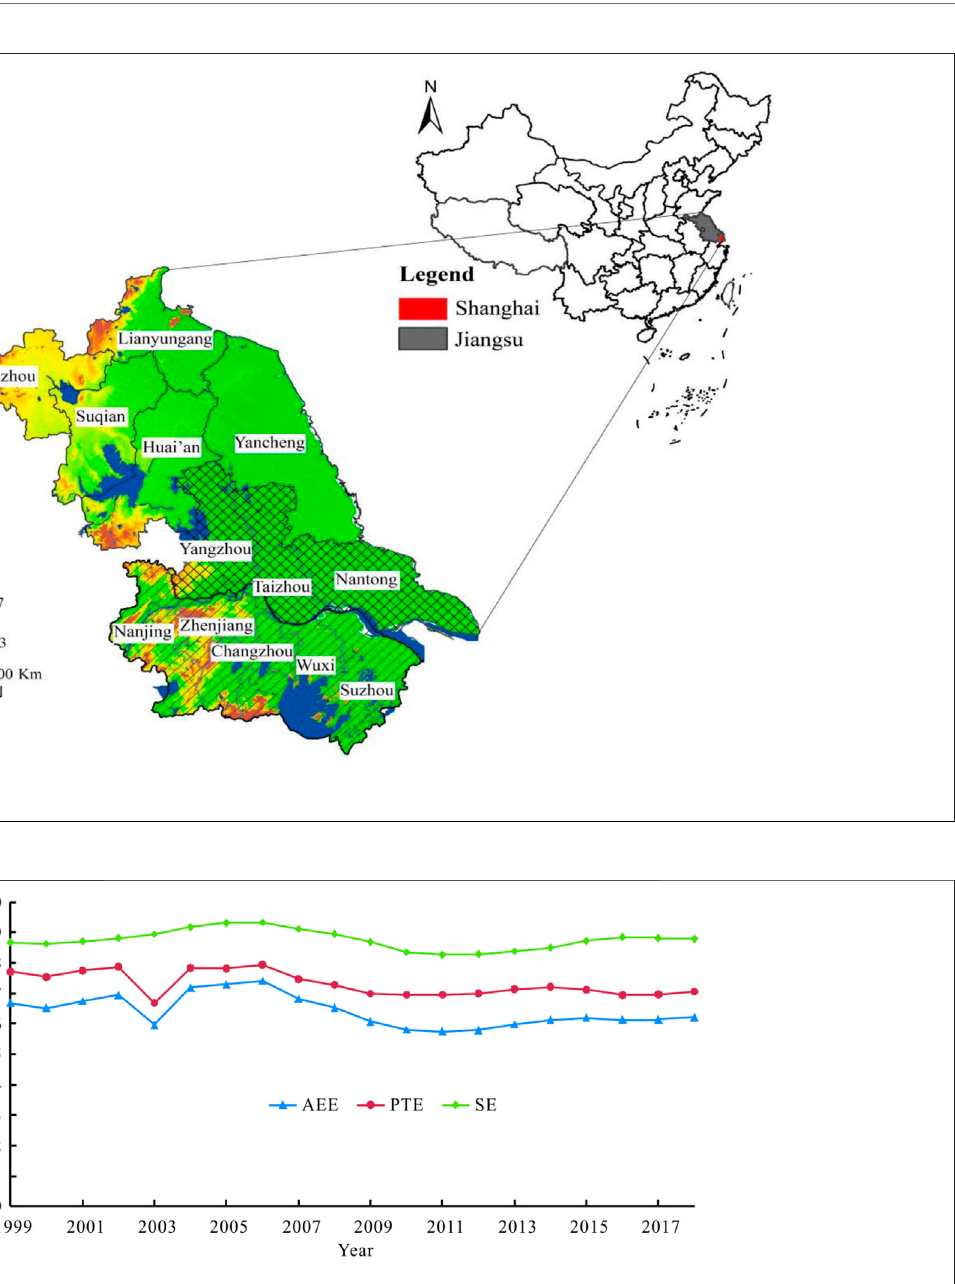
Frontiers in Energy Research |